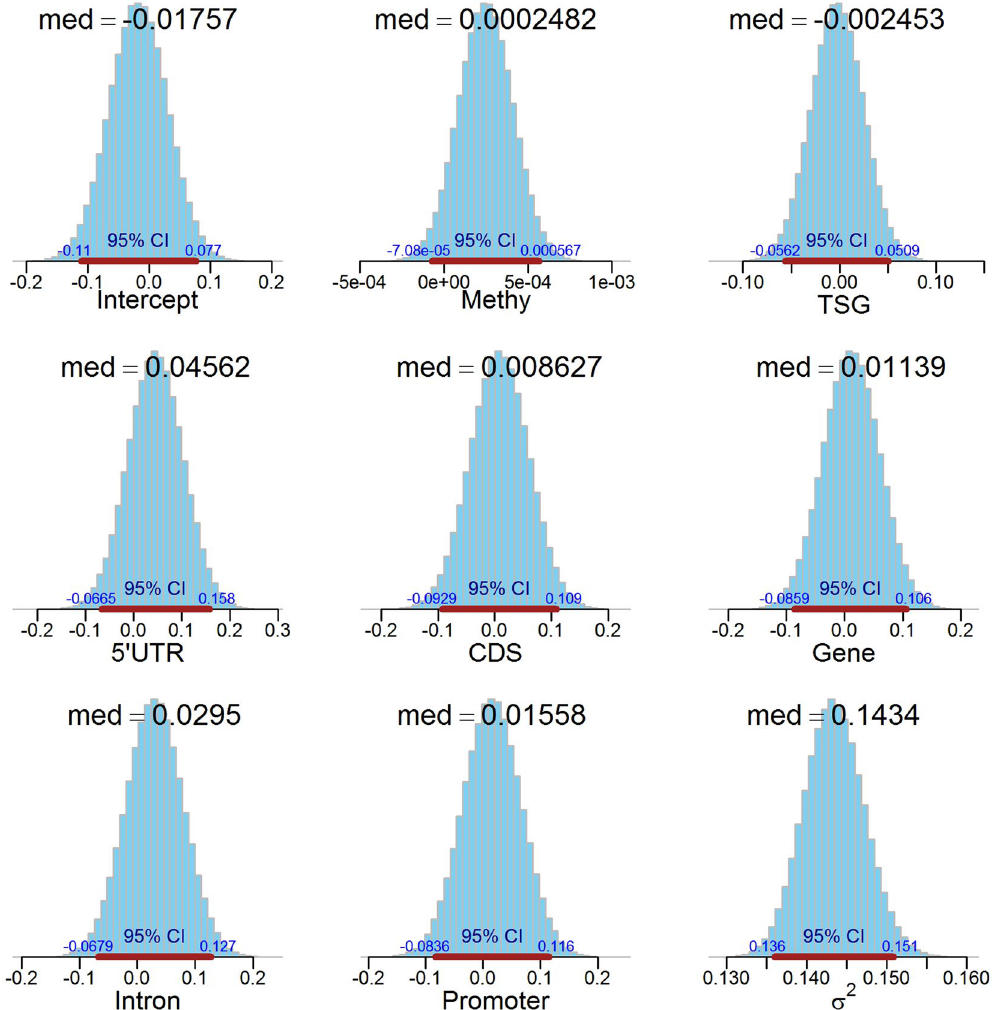
Figure 5. Statistics for Gaussian regression for differential expression (log2 fold change from RNA-seq) based on methylation level, TSG status, and DMR annotation region distribution (gene body, intron, promoter, 5 ′ UTR, 3 ′ UTR and CDS). Each plot lists the median (med) for sampling distribution, together with 95% confidence interval (CI) and start/end